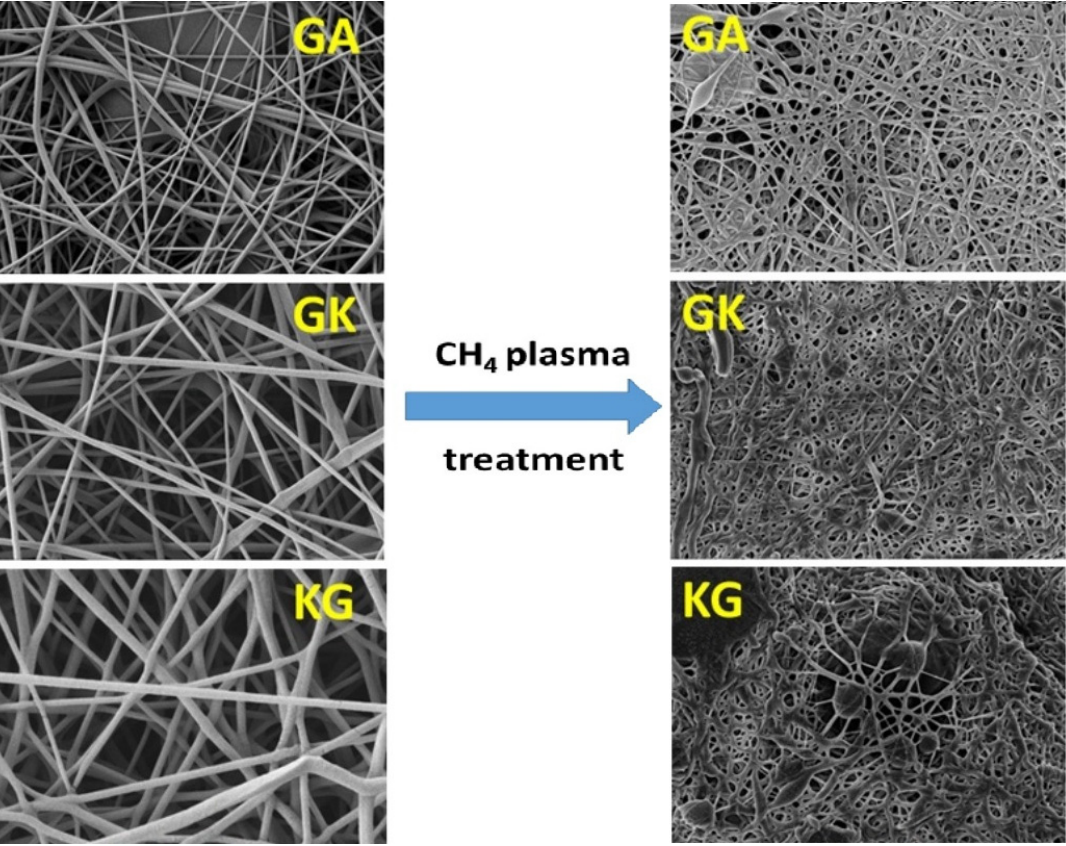
Figure 6. SEM images of polyvinyl alcohol (PVA)/gum Arabic (GA), PVA/gum Karaya (GK), and PVA/Kondagogu gum (KG) before and after plasma treatment [19]. (Reprinted with permission from Padil et al., 2016.)